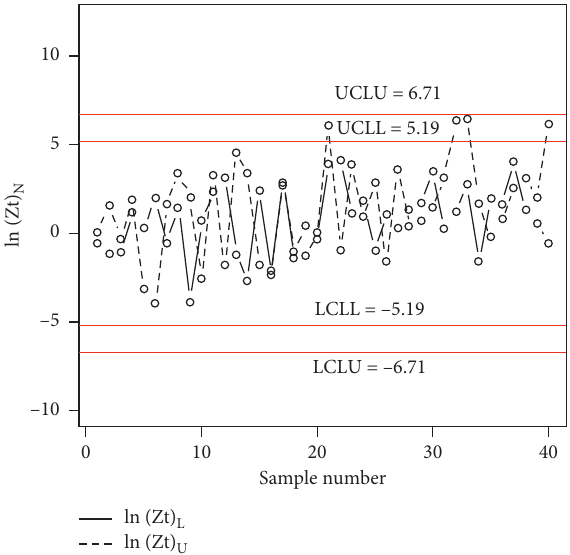
Figure 2: The existing chart proposed by Aslam et al. [44].